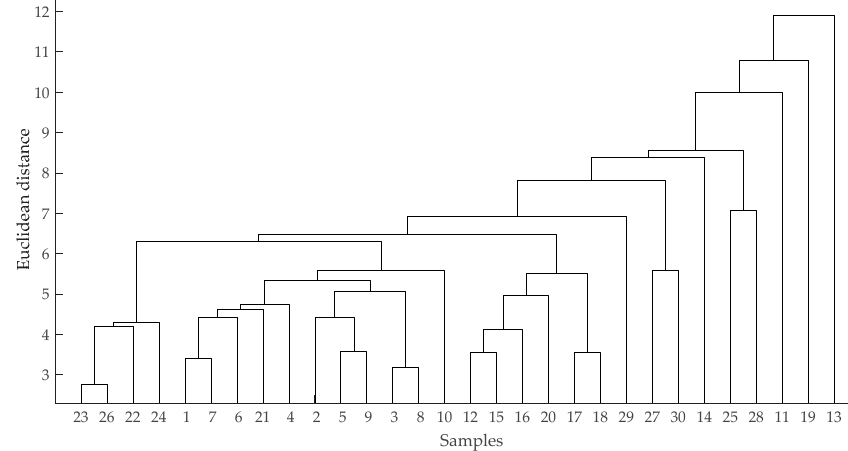
Figure 2. Hierarchical diagram of volatile compounds. Sample 1–10: Tan; Sample 11–20: Hu; Sample 21–30: Dorper.